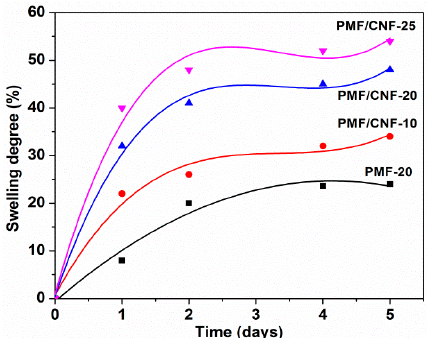
Figure 4. ( a , b ) AFM images of PMF-20/CNF composite with 10 and 25% ( v / v ) CNFs; ( c , d ) SEM images of PMF-20/CNF composite with 10 and 25% ( v / v ) CNFs.